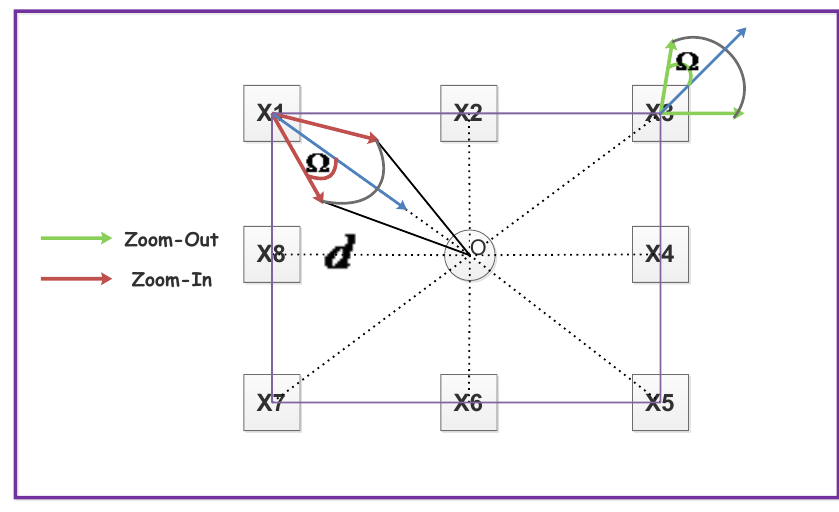
Figure 3. An illustration of the camera zoom in and out